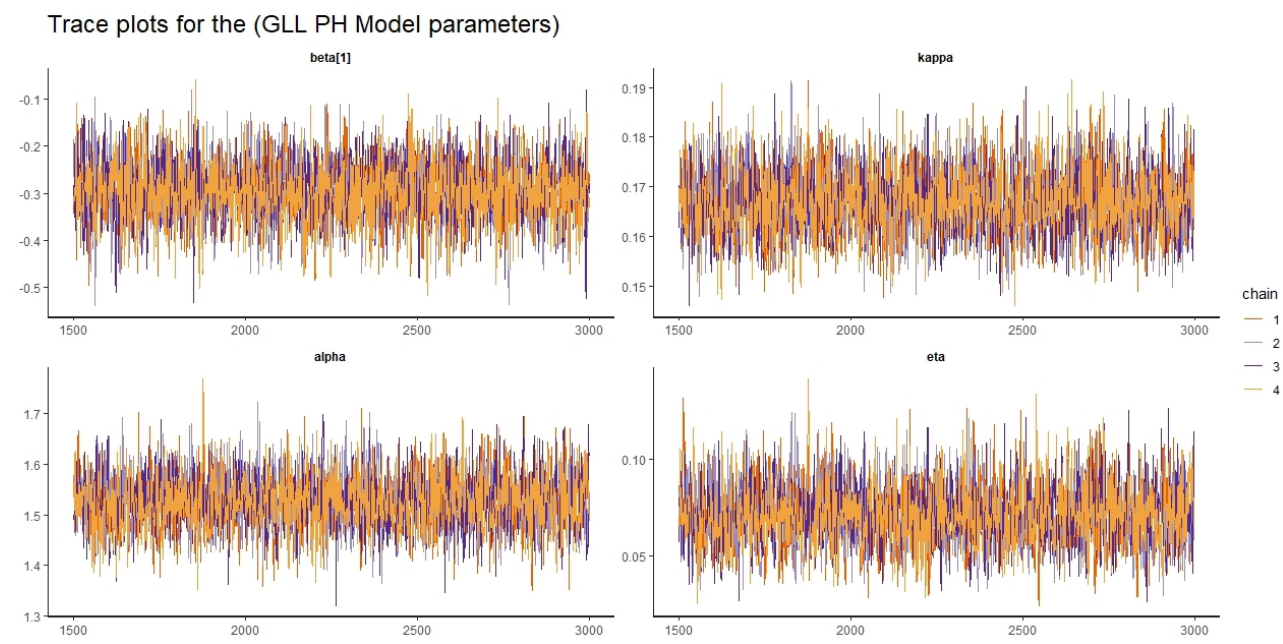
Figure 9. Trace plots for the GLL − PH model